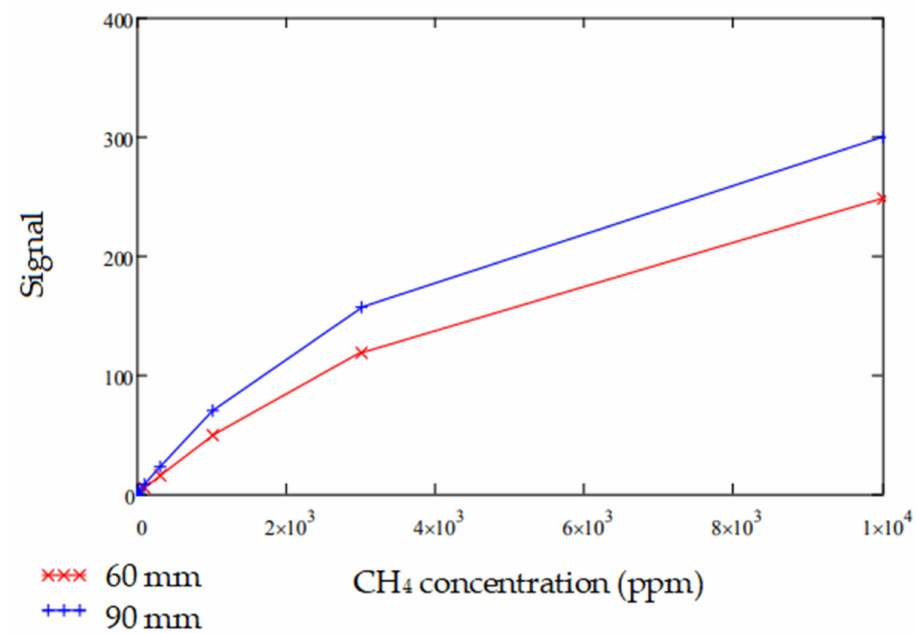
Figure 20. Change in signal modelled for different path lengths 60 mm and 90 mm for CH 4 gas concentrations below 10,000 ppm.